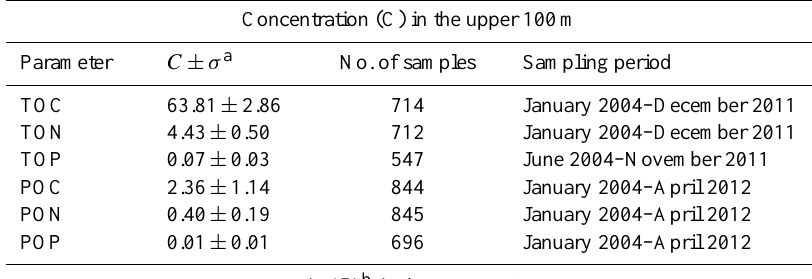
Table 1. Average concentration (µmolkg − 1 ) , molar ratio of various biogeochemical parameters and particle fluxes (mmolm 2 d − 1 ) from the BATS data presented in Fig.